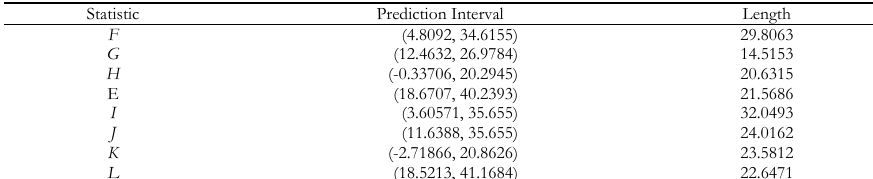
Prediction intervals for species data using SRS and MRSS